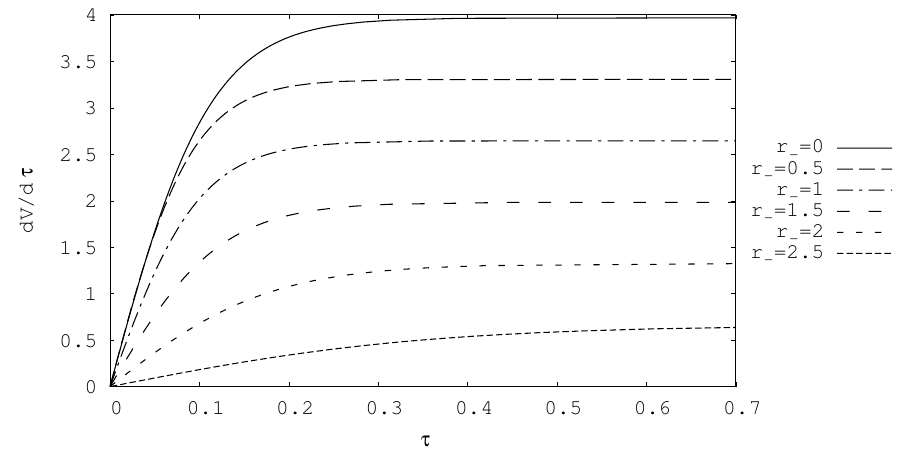
Figure 3 . Time dependence of dV in units of (cid:25)l , for r + = 3, (cid:23) = 2 and several values of r (cid:0) . For d(cid:28) other values of (cid:23) the plots are qualitatively